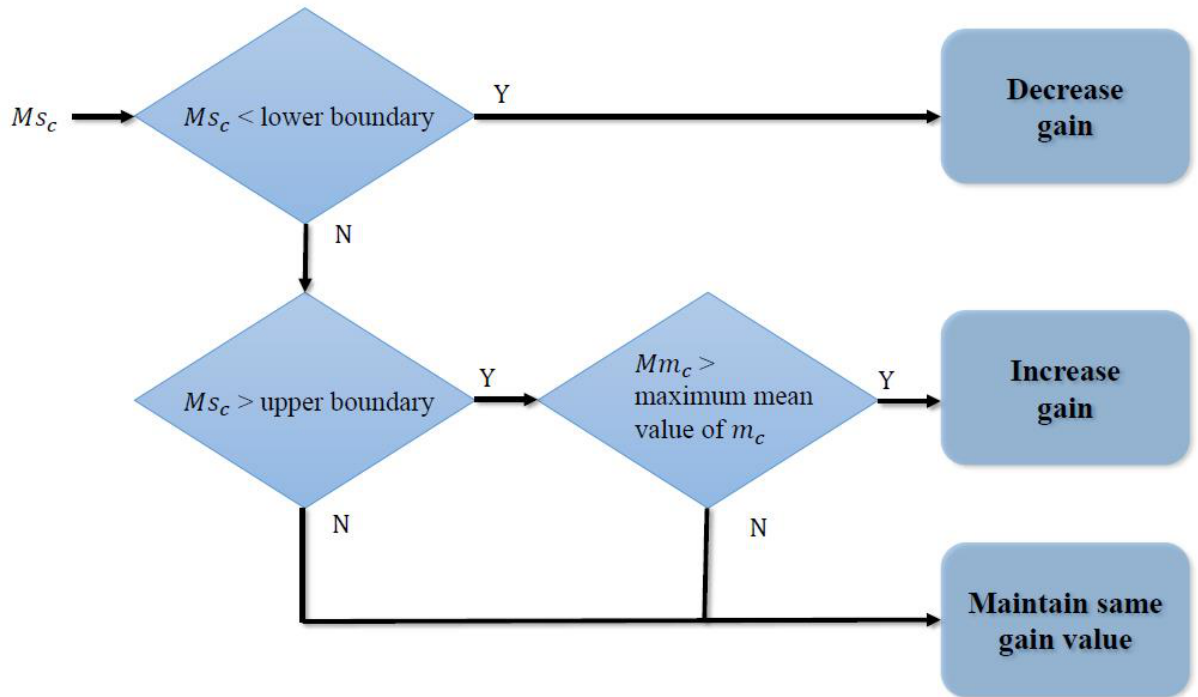
Figure 12. Flowchart of the proposed strategy for bandwidth selection.